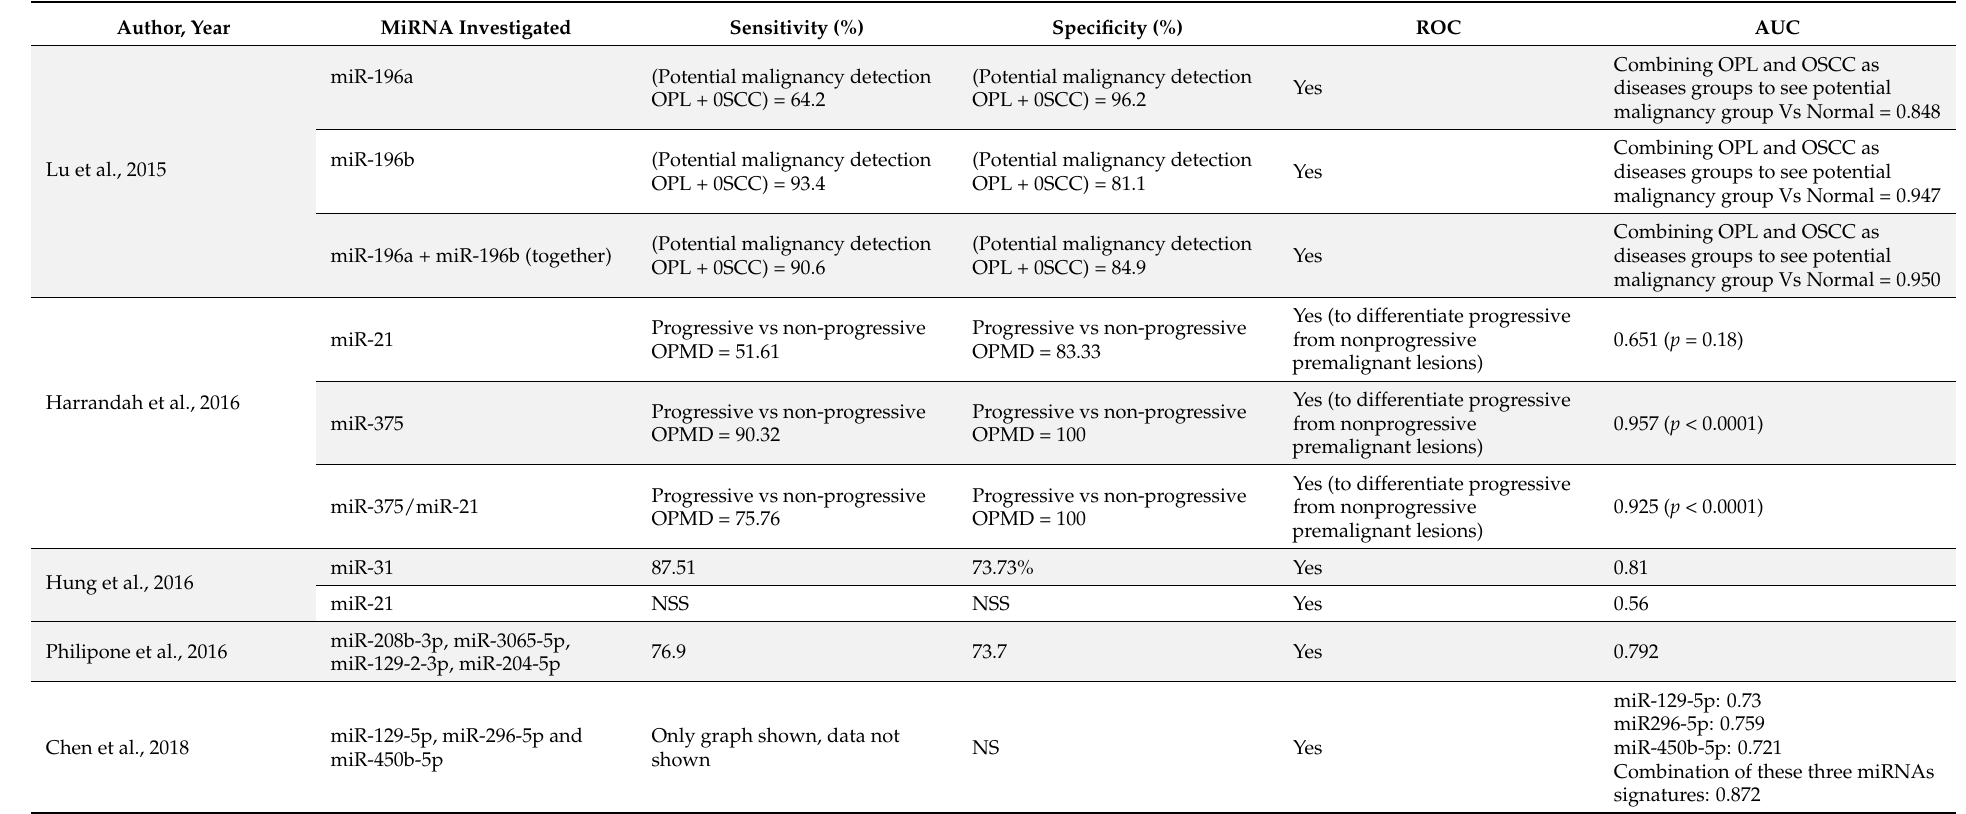
Table 5. MiRNAs predicting malignant transformation in oral leukoplakia and oral epithelial